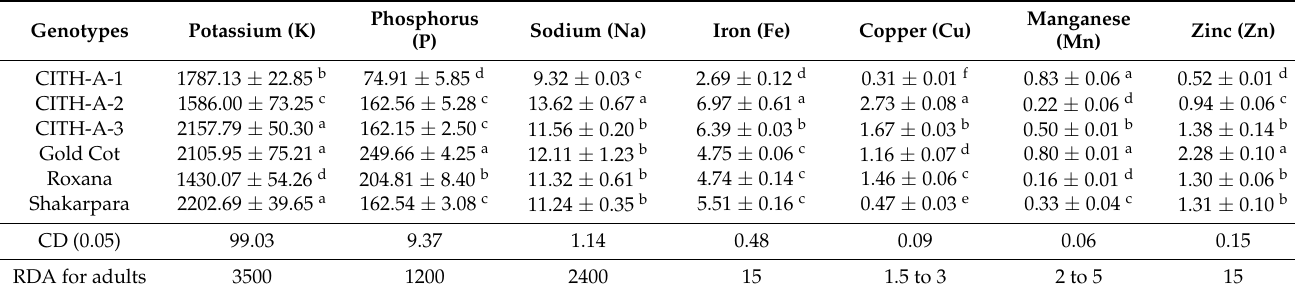
Table 4. Variation in mineral content of different apricot